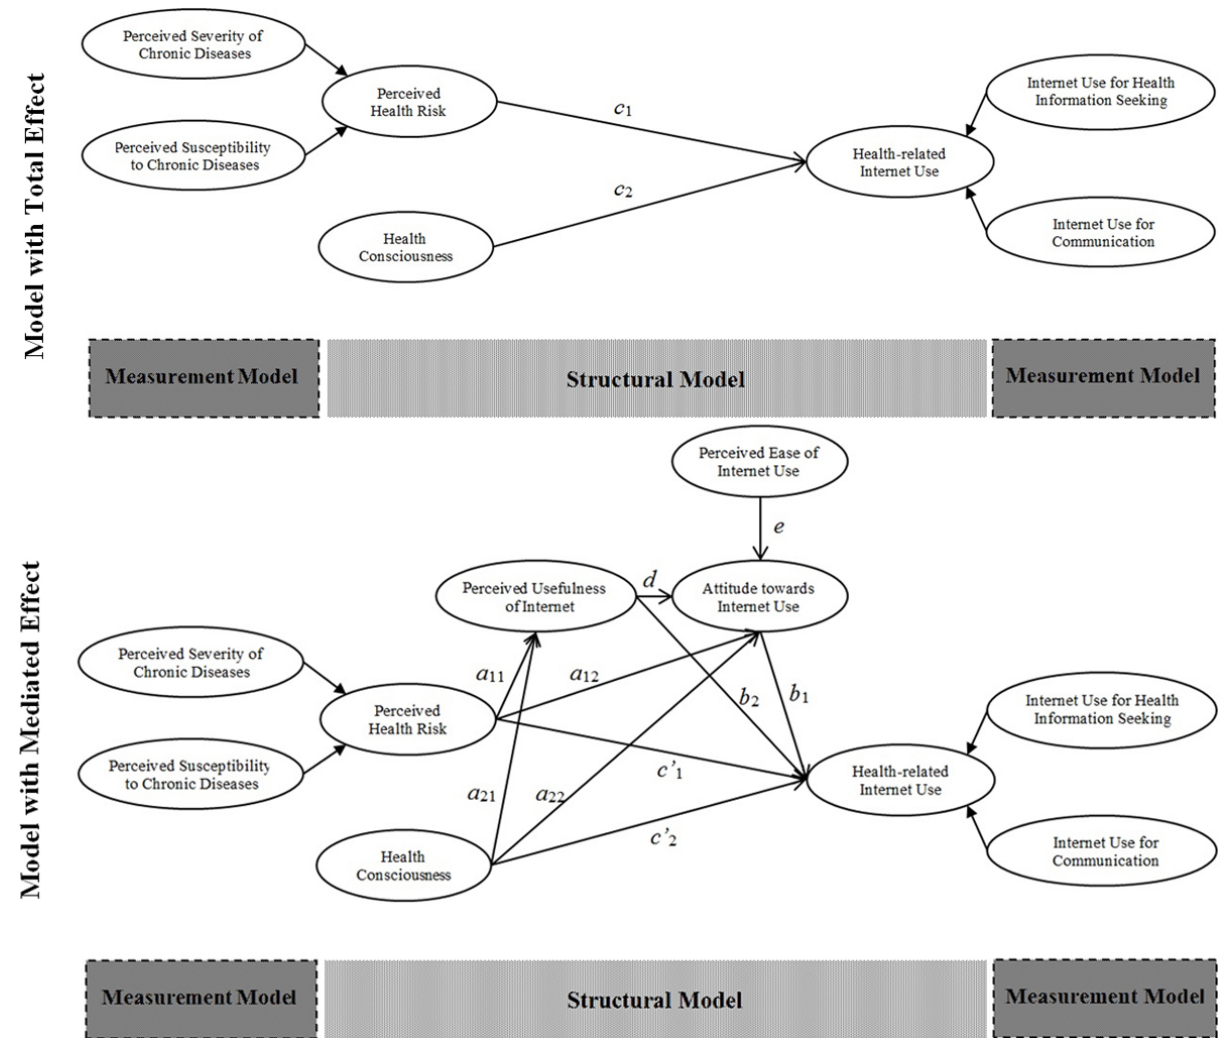
Figure 4. Structural research